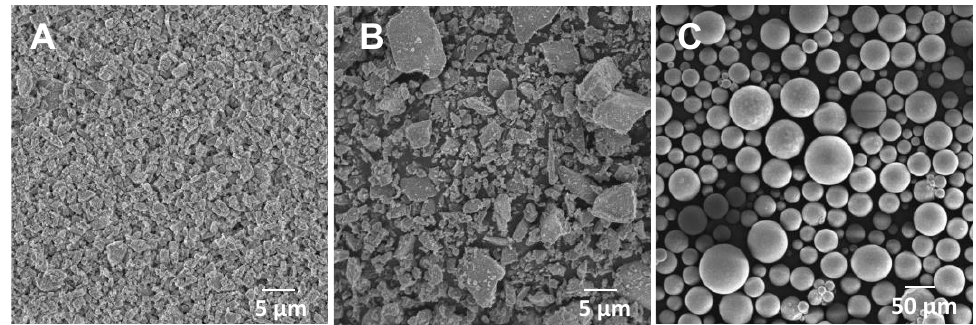
Figure 1. Representative scanning electron microscopy (SEM) images of ( A ) surface pre-reacted glass ionomer (S-PRG)-1, ( B ) S-PRG-3, and ( C ) auto-polymerizing resin (APR) powder.